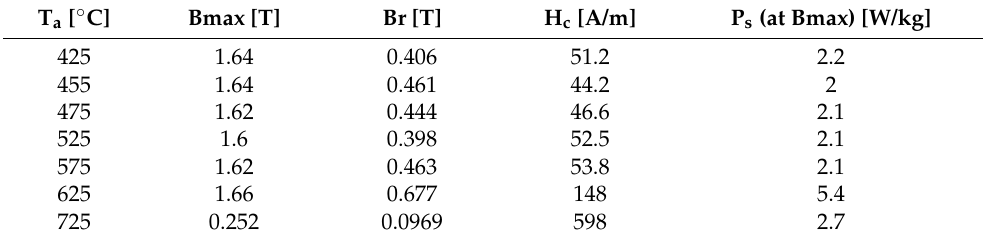
Table 2. The influence of the annealing temperature Ta on the magnetic properties of the Fe 64.5 Co 20 Nb 5 B 8.5 P 2 alloy, for which the hysteresis loops have been measured at 50 Hz, with a maxi- mum applied field of 1500 A/m.